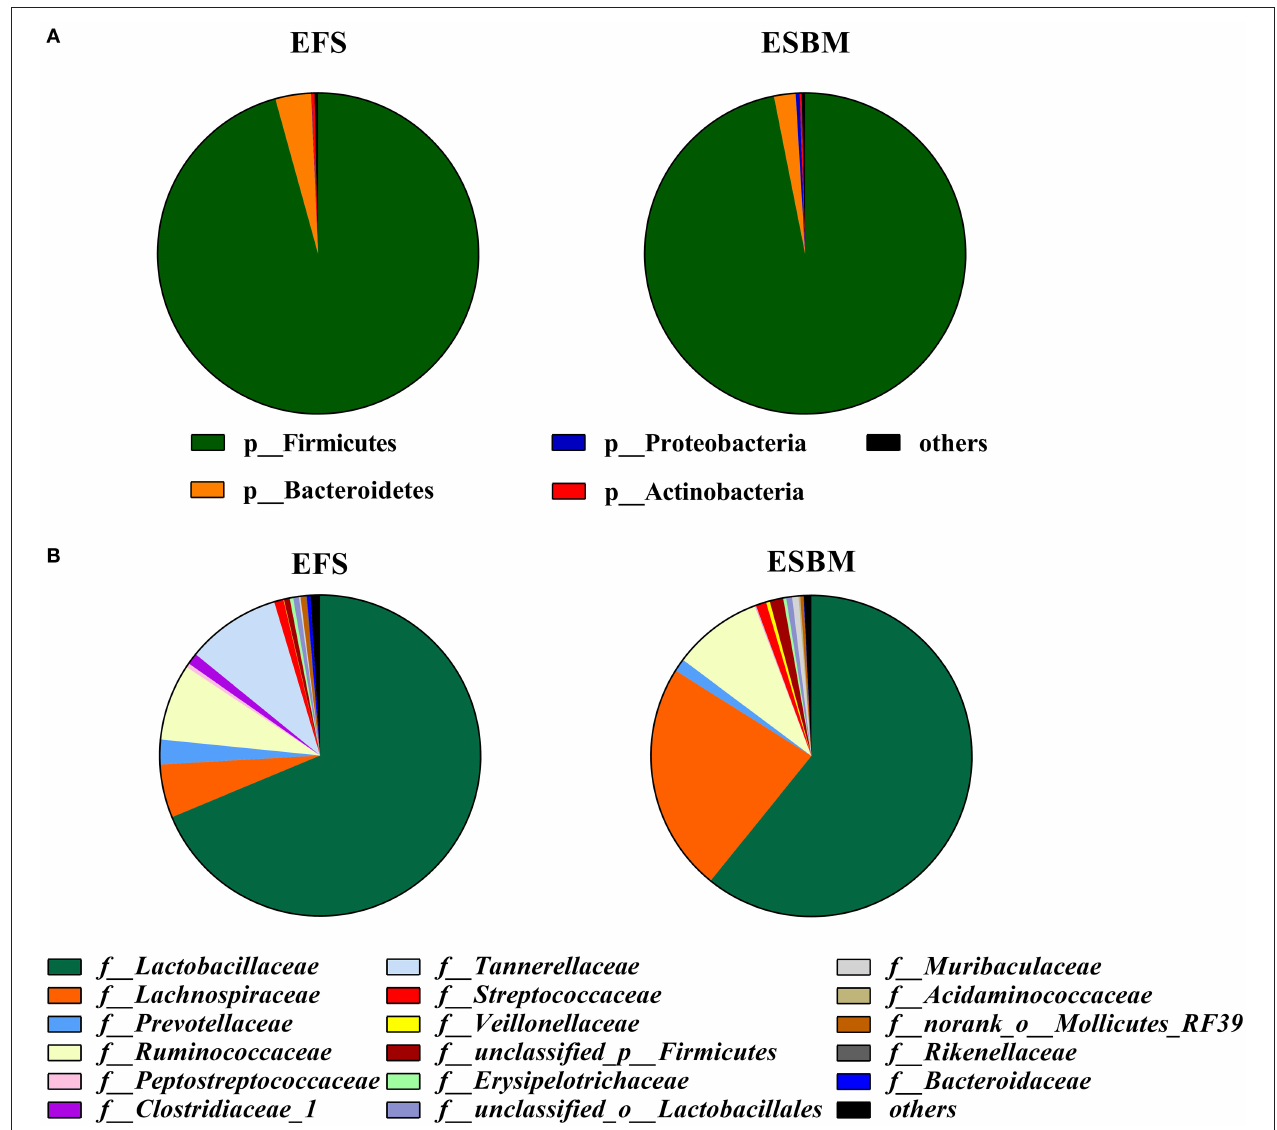
FIGURE 2 | Effects of protein source on the cecal microbial composition at the phylum level (A) and the family level (B) (at least one sample relative abundance ≥ 0.1%) in piglets (%). The individual minipig was regarded as the experimental unit, n = 5 for EFS, n = 5 for ESBM. EFS, extruded full-fat soybean; ESBM, enzyme-treated soybean